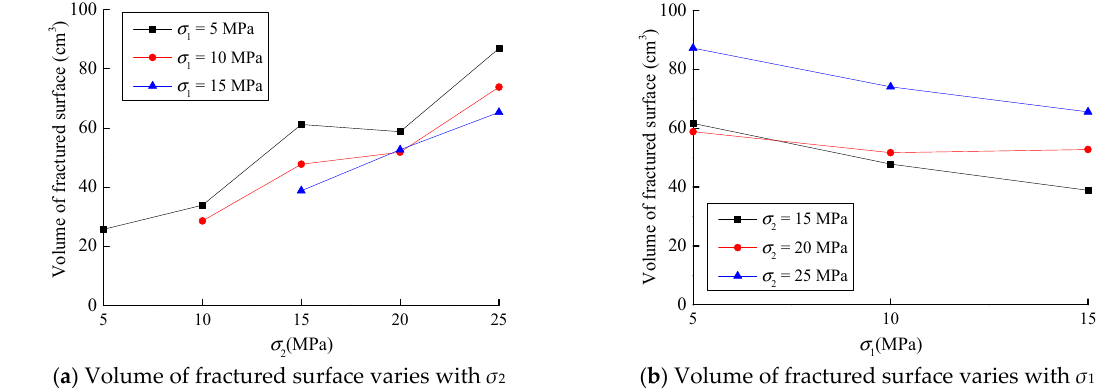
Figure 11. Volume of fractured surface under different confining pressures.